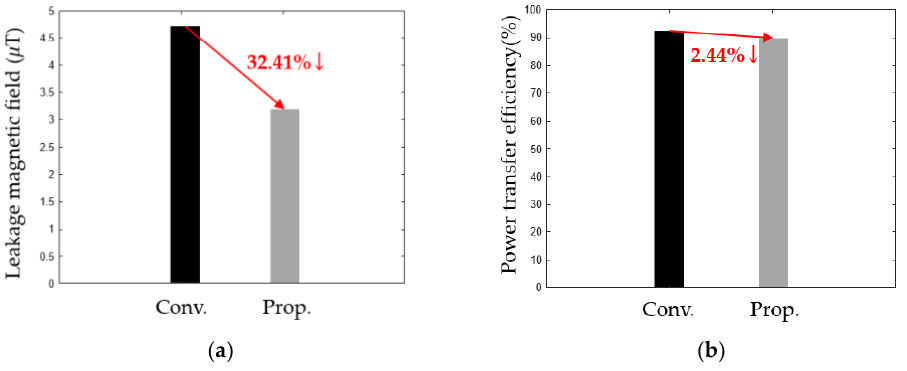
Figure 17. Experiment results: ( a ) leakage magnetic field level; ( b )